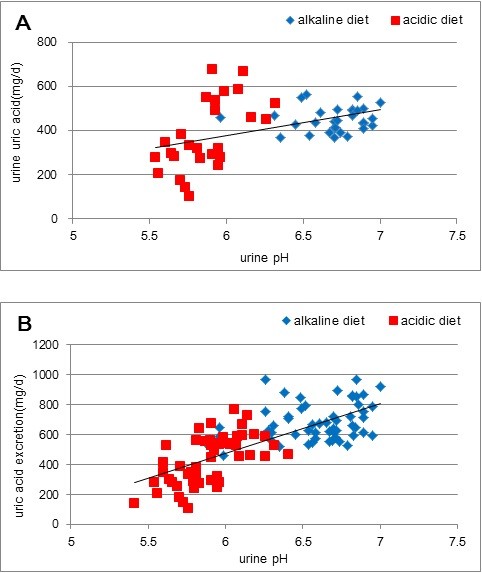
Relationship between excreted uric acid as expressed in mg uric acid in urine per day and urine pH. In A. Diamonds indicate data for the alkaline diet and squares those for the acidic diet. The equation for the straight line obtained by the least square method is y = 118.9x-335.8 (r2 = 0.2098, n = 57, p < 0.01). In B. Corrected relationship between excreted uric acid as expressed in mg uric acid in urine per day and urine pH. Given the loading difference of purine bodies, data for uric acid excreted in alkaline urine were multiplied by correction factors, as described in the text. The equation for the straight line obtained by the least square method is y = 332.25x-1525.6 (r2 = 0.5406, n = 57, p < 0.01).